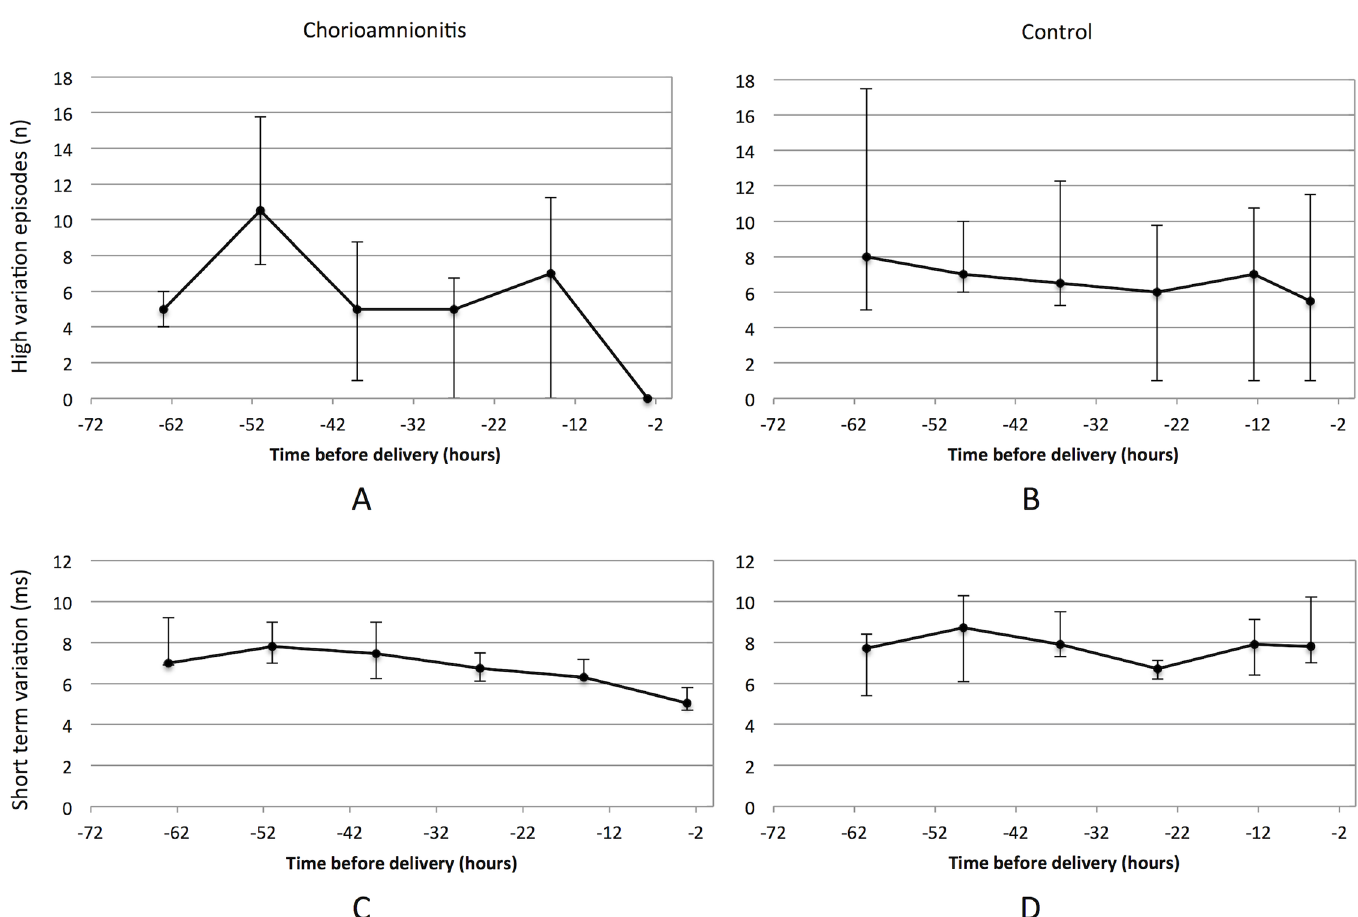
Fig 2. Linearrepresentation of high variation episodes(figures A and B; median and interquartilerange) and STV (figures C and D; medianand interquartile range) duringthe six last cCTG before delivery.The cCTG parameters were collectedevery 12 h at the same time (around 8:00 a.m. and p.m.).